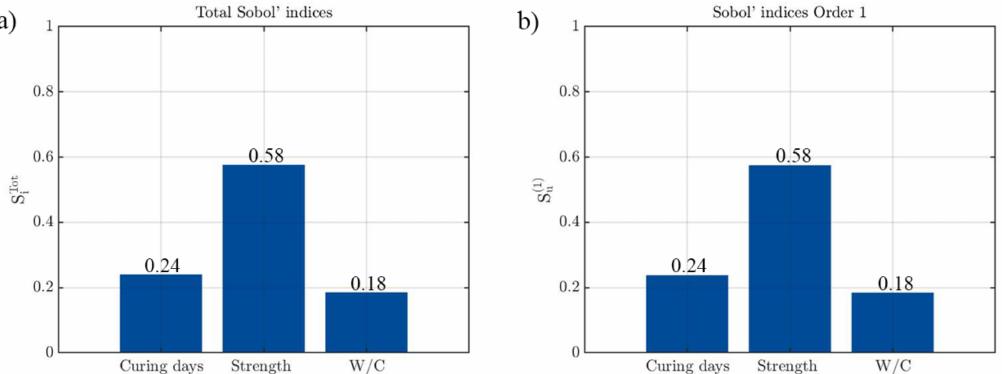
Figure 16. Results obtained during the sensitivity analysis of CDWRCer: ( a ) Total Sobol’indices and; ( b ) First-order